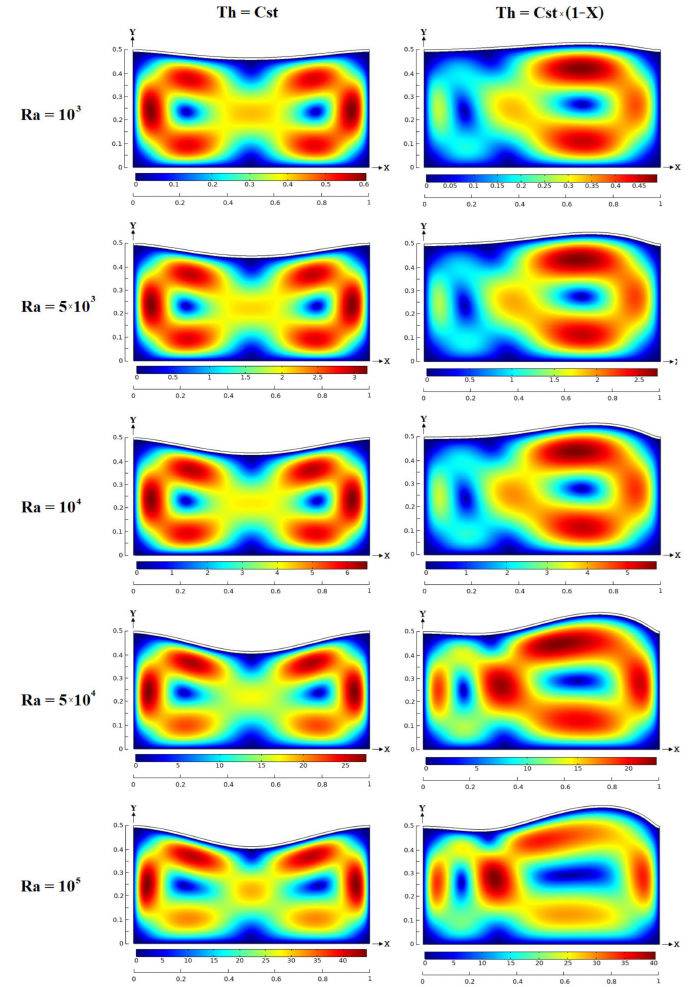
Figure 5. Combined effects of hot temperature distribution and Rayleigh number on nanofluid velocity magnitude